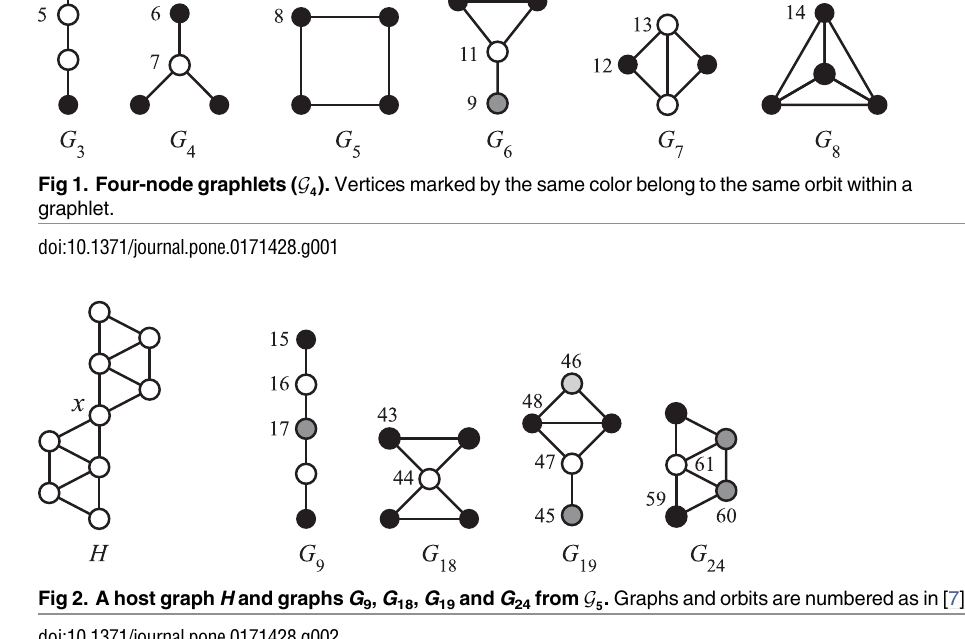
Fig 2. A host graph H and graphs G 9 , G 18 , G 19 and G 24 from G